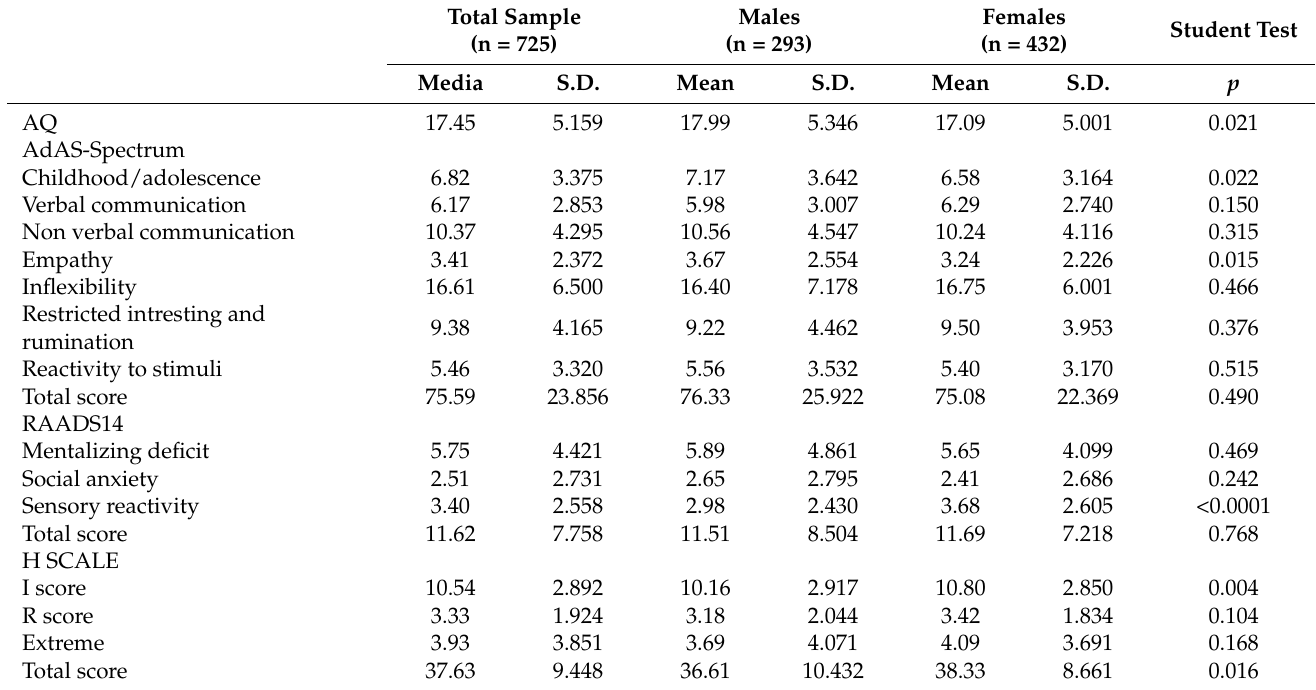
Table 1. Descriptive statistics and gender differences on psychological tests